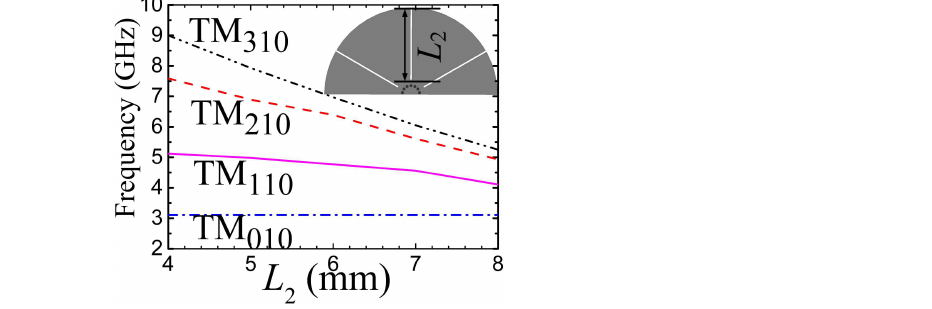
Figure 8. Variations of resonant frequencies with three slots etched on the semicircular resonator under changed parameter L 2 .